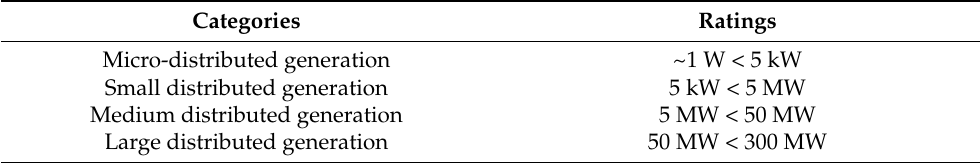
Table 1. Ratings of distributed generation. Source: adapted from